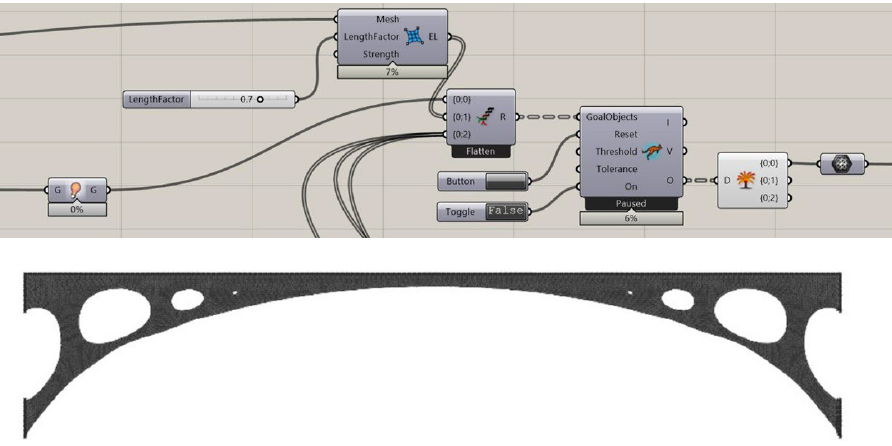
Figure 22. Kangaroo form-finding development and solution.